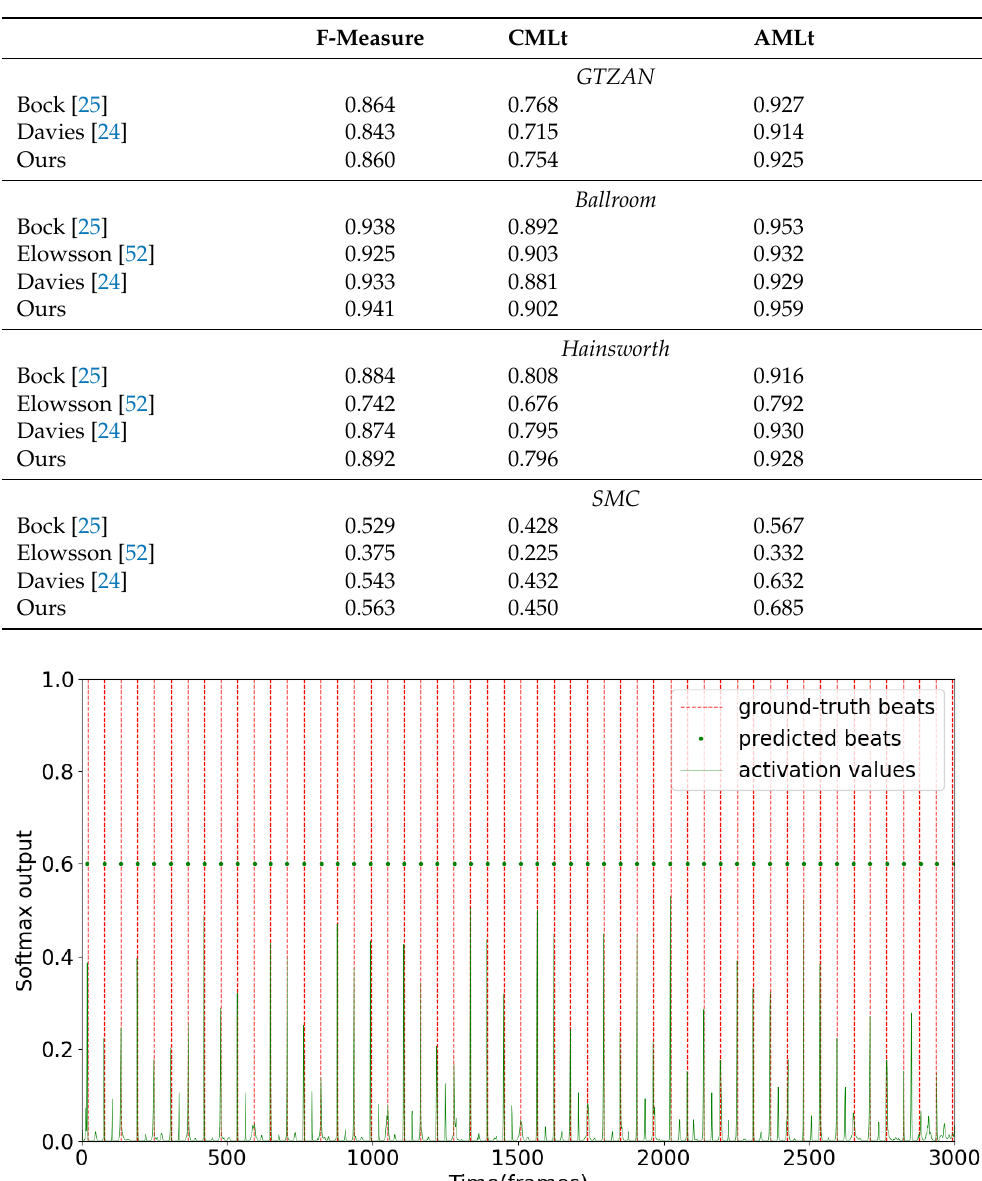
Table 2. Evaluation Results on GTZAN, Ballroom, Hainsworth, and SMC datasets for beat tacking. Evaluation metrics of F-measure, CMLt, and AMLt are shown.